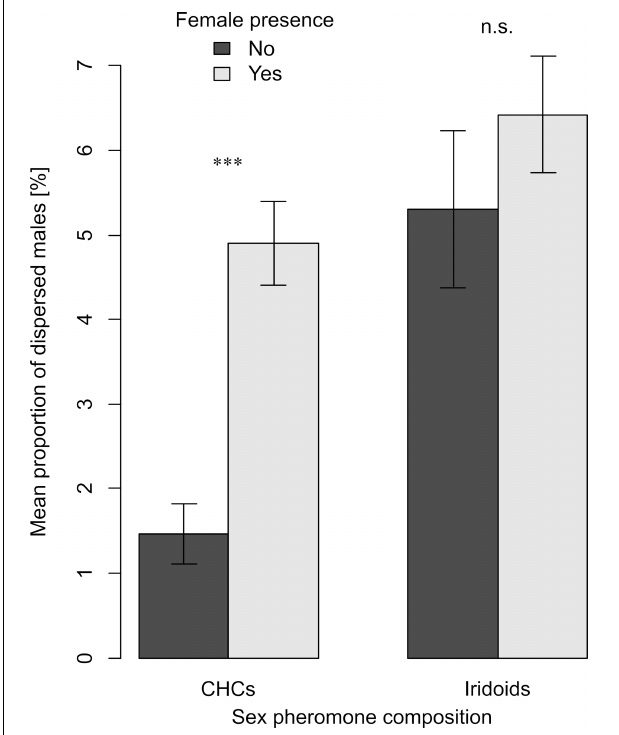
FIGURE 3 | Barplots showing means and standard errors of the mean proportions of dispersed males within the 48 h before (dark gray bars) and within the 48 h after (light gray bars) female emergence in each jar for species using CHCs ( L. pacifica and L. ryukyuensis ) or iridoids ( L. heterotoma , L. japonica ) in the female sex pheromone. Dispersal before and after female emergence was compared with Wilcoxon signed rank tests (Bonferroni corrected). Asterisks indicate a significant difference *** P < 0.001, n.s. not significant. For each experiment, N =